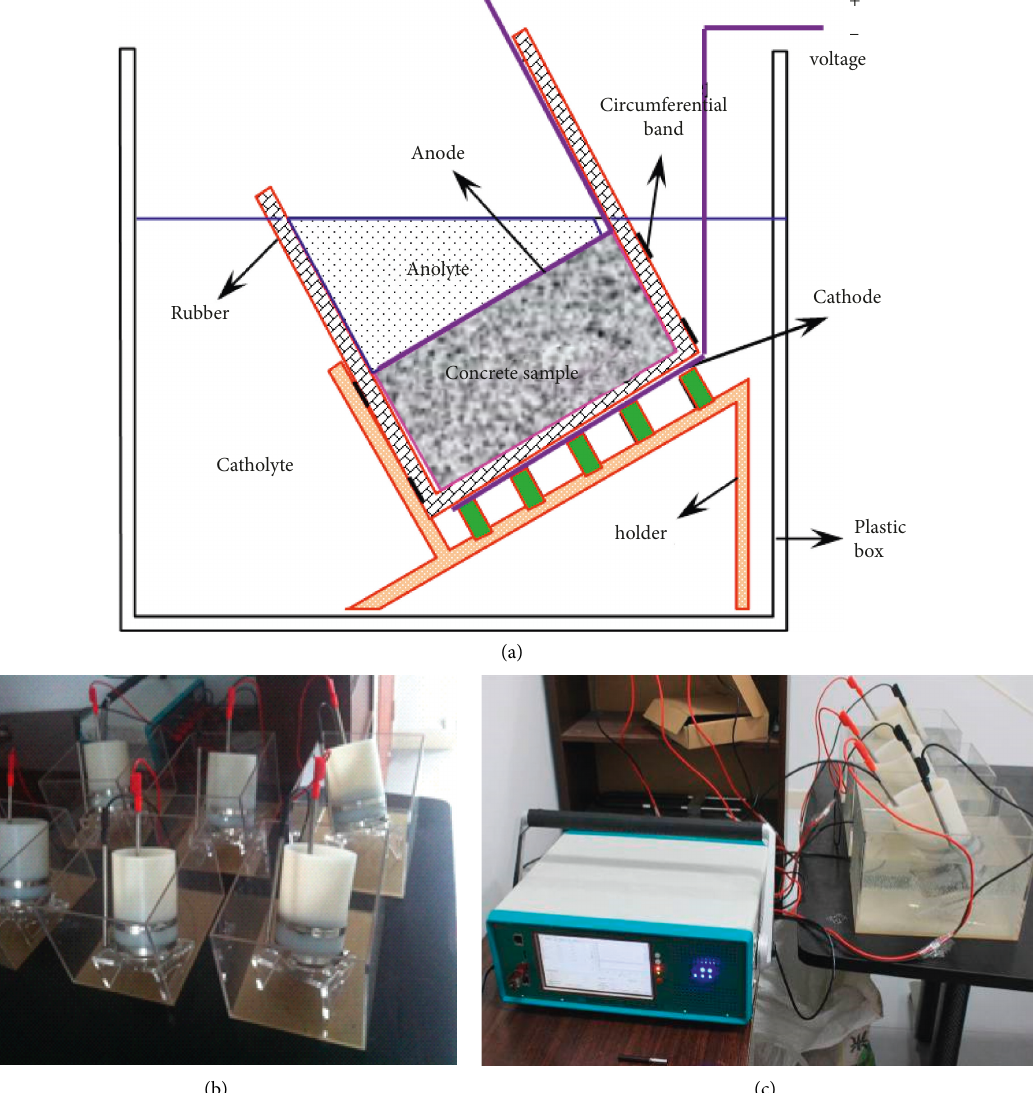
Figure 4: Setup for rapid chloride migration test (RCM): (a) schematic diagram, (b) apparatus for the test samples, and (c) data acquisition